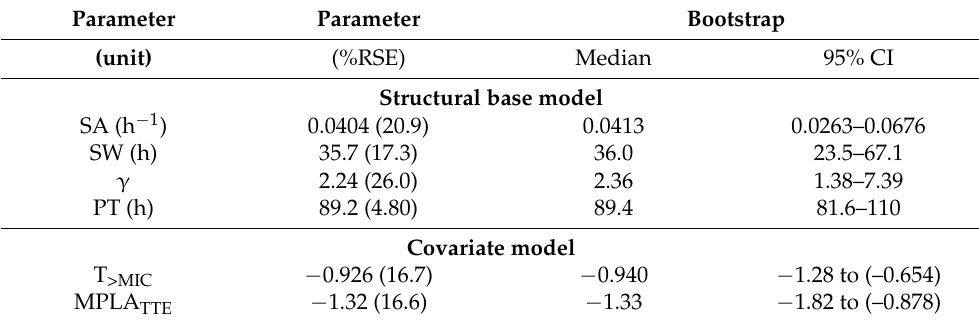
Figure 3. Visual predictive check of the overall survival model (n = 1000 simulations including unexplained variability) for different study groups of mice infected with Streptococcus pneumoniae serotype 1 and untreated or treated with AMX with or without coadministration of MPLA: Solid lines: Observed survival; Dashed lines: Simulated survival; 90% confidence interval around simulated survival as shaded area. Abbreviations: AMX: Amoxicillin (0.40 mg/kg or 1.20 mg/kg); MPLA: Monophosphoryl lipid A (2.00 mg/kg); +: Treatment with respective drug; –: No treatment with respective drug. Table 2. Model parameter estimates including bootstrap results (convergence rate of 100%) of the time-to-event analysis of survival data of mice untreated or treated with amoxicillin and/or monophosphoryl lipid A.